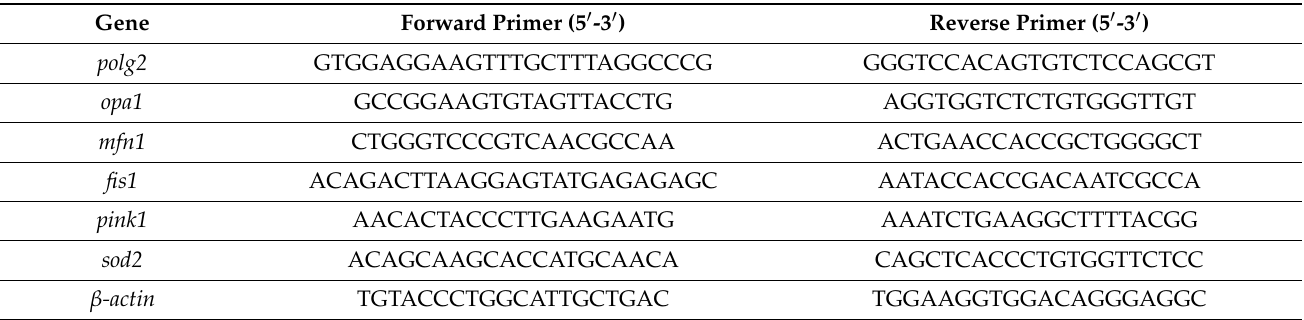
Table 1. RT-qPCR primers used in this